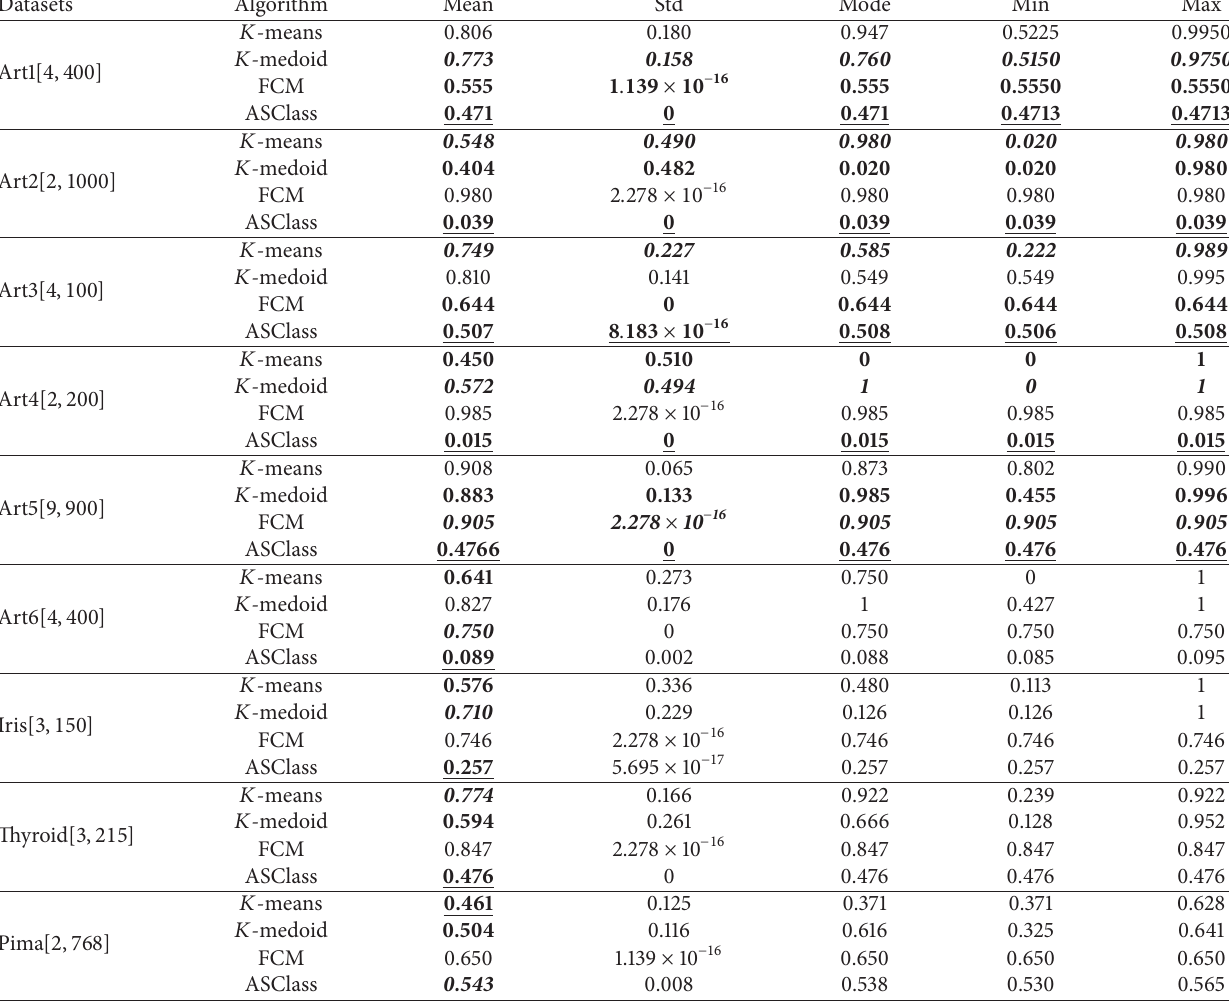
Table 4: Mean, standard deviation, mode, min, and max values of error rate achieved by each clustering algorithm ( 𝐾 -means, 𝐾 -medoid, FCM, and ASClass) over 20 trials on dataset presented in Table 2.